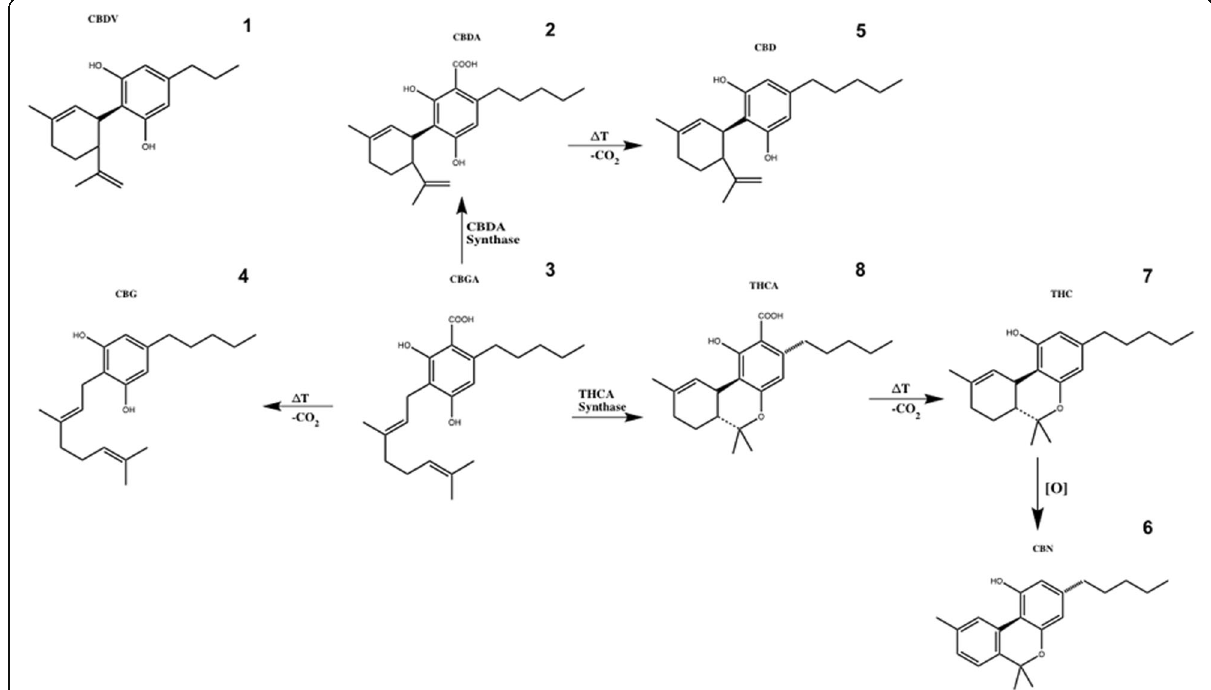
Fig. 1 Biosynthetic pathway of selected